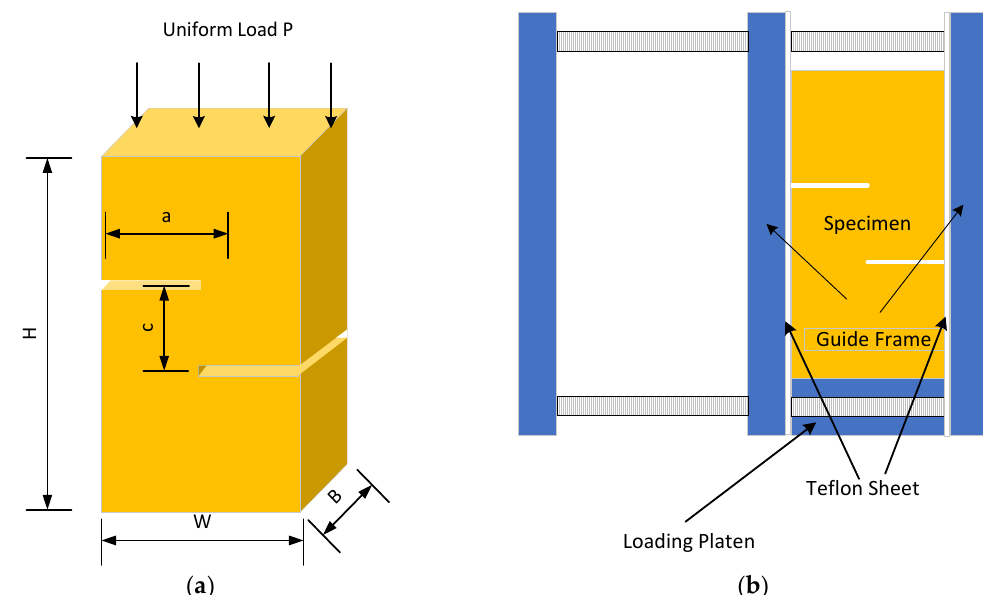
Figure 4. Short-beam compression test: ( a ) specimen geometry; ( b ) test set-up.